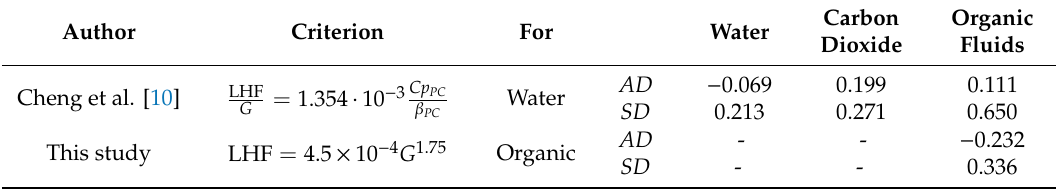
Table 5. The criteria of the LHF of water and carbon dioxide